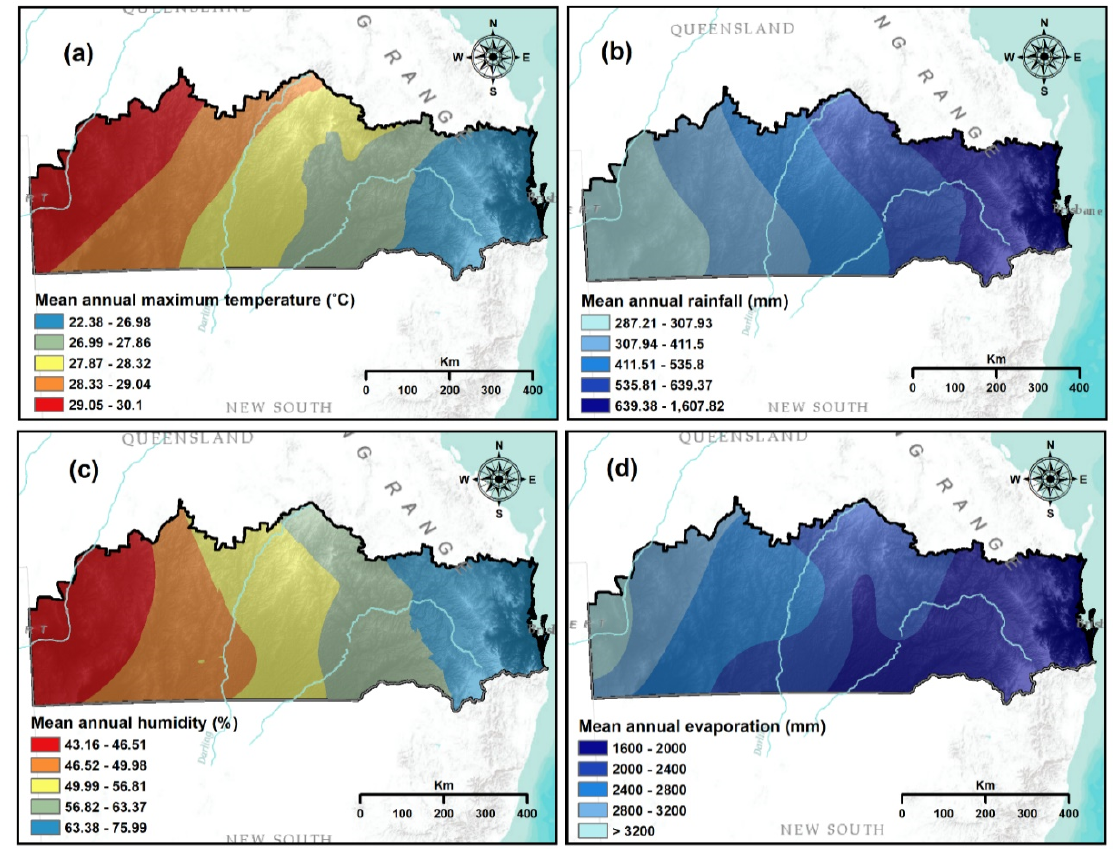
Figure 3. Thematic layers used for meteorological drought vulnerability: ( a ) mean annual maximum temperature; ( b ) mean annual rainfall; ( c ) mean annual humidity; and ( d ) mean annual evaporation.